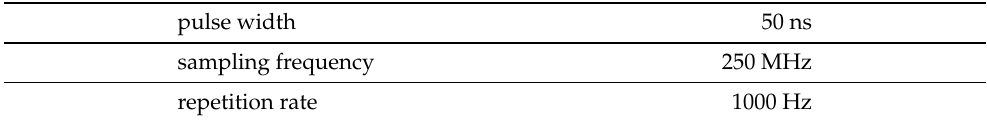
Table 2. Parameters of the Φ -OTDR system.